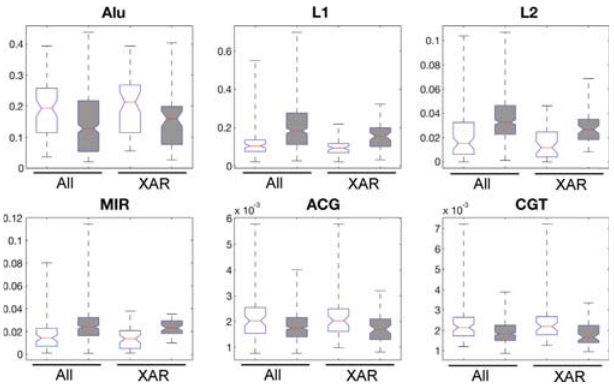
Figure 2. Boxplots Representing the Content of Alu, L1, L2, MIR, and ACG/CGT 3-mers in 100-kb Windows Surrounding the Transcription Starts of Genes For each boxplot, horizontal lines indicate the locations of the lower quartile, median, and upper quartile values. Notches represent a robust estimate of the uncertainty about the medians for box-to-box comparison. Boxes whose notches do not overlap indicate that the medians of the two groups differ at the 0.05 significance level. Clear boxes represent genes that escape inactivation, while shaded boxes represent genes subject to inactivation [12]. Analyses were done with all genes for which X inactivation status is known ( n ¼ 448) or with genes from the XAR region ( n ¼ 110). y -Axes in all plots represent the average content of each sequence feature in 100-kb windows surrounding the transcription starts of genes. DOI: 10.1371/journal.pcbi.0020113.g002